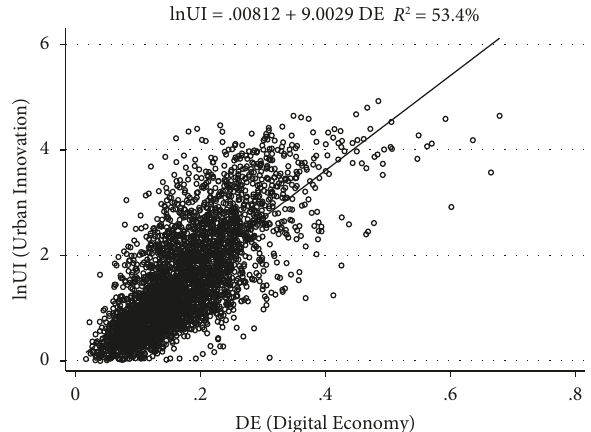
Figure 5: Fitted scatter plot of urban innovation and digital Table 5, the coefficient estimates of the direct effects, indirect effects, and total effects of the digital economy on urban innovation are 1.095, 4.368, and 5.463, respectively; they are